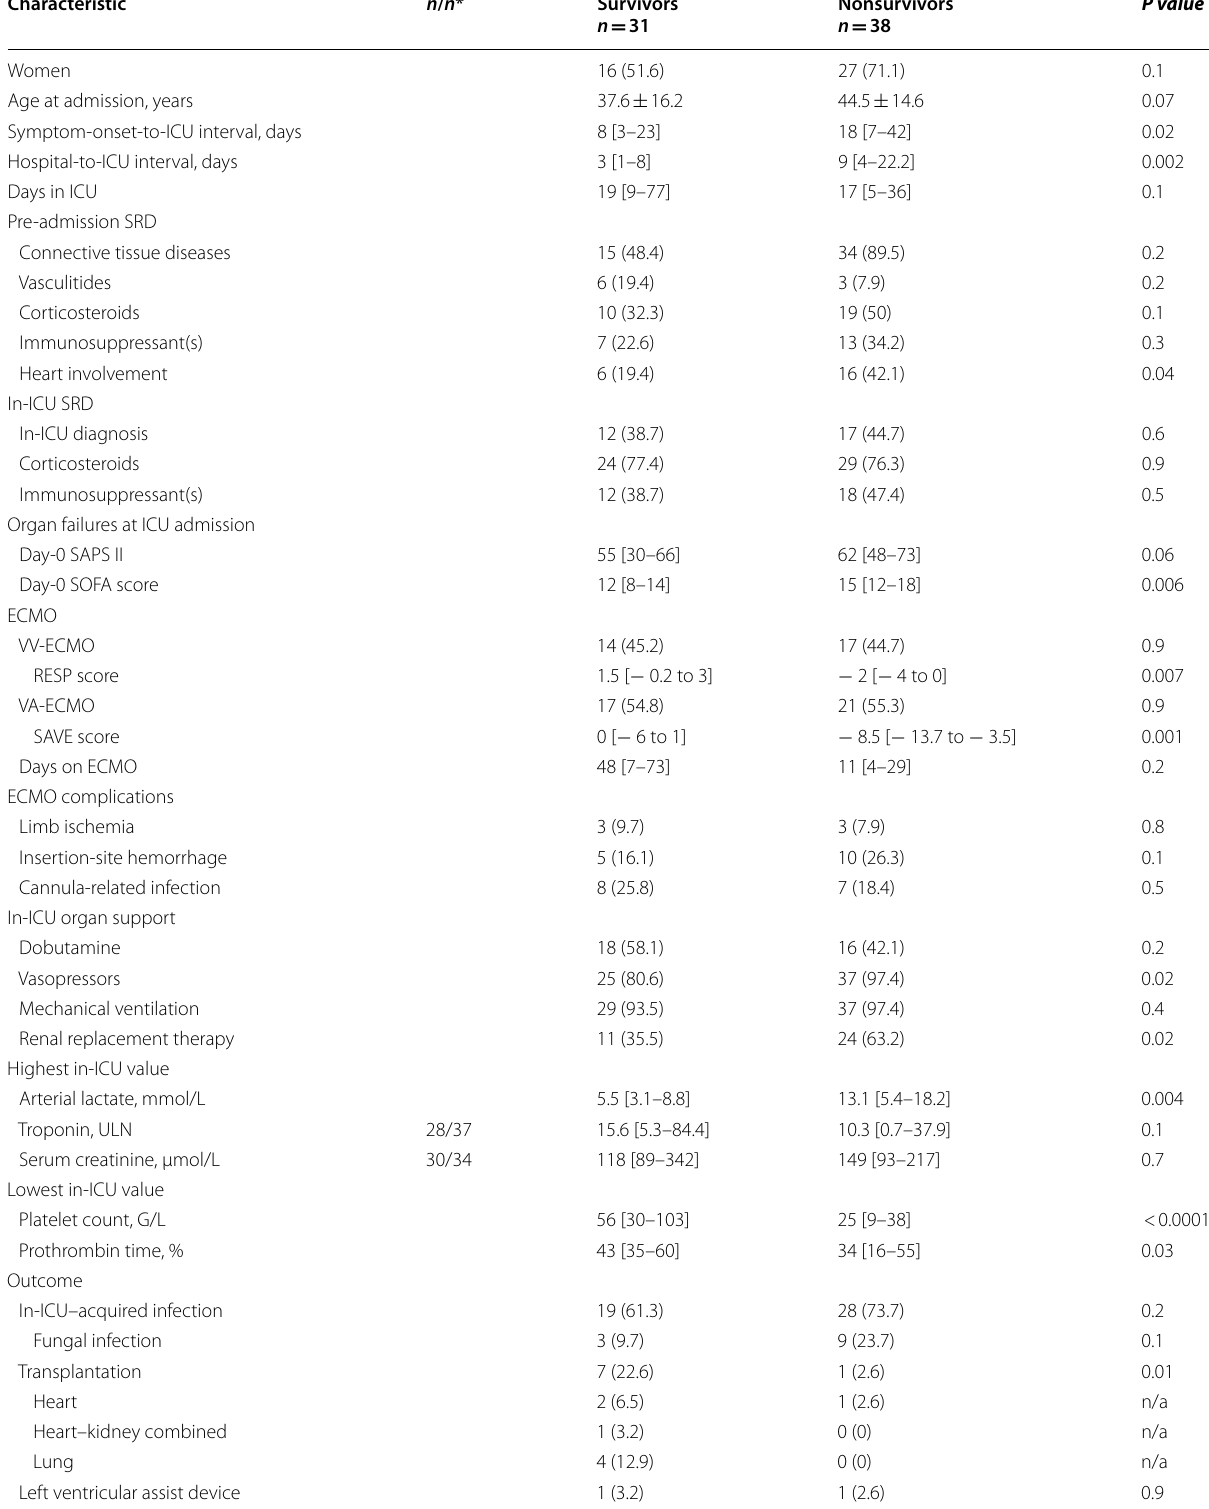
Table 4 In-ICU characteristics and outcomes of the 69 ECMO-treated SRD flare patients: hospital survivors vs.